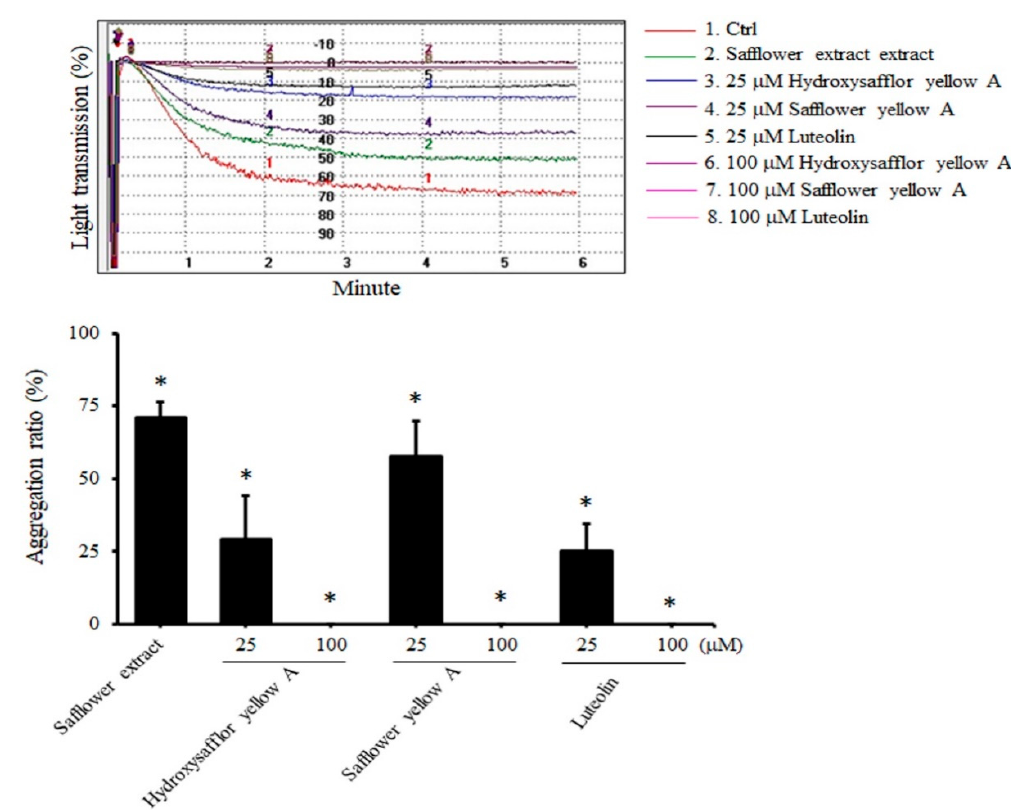
Figure 2. The compounds found in the safflower extract inhibited platelet aggregation. PRP was treated with 50 µ g/mL safflower extract or 25–100 µ g/mL compounds found in the safflower extract, and ADP was added and analyzed by an aggregometer. * p < 0.05 compared with the control group.